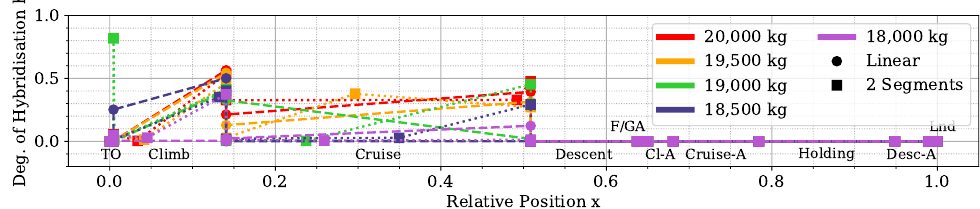
Figure 14. Energy management strategies for different take-off mass constraint